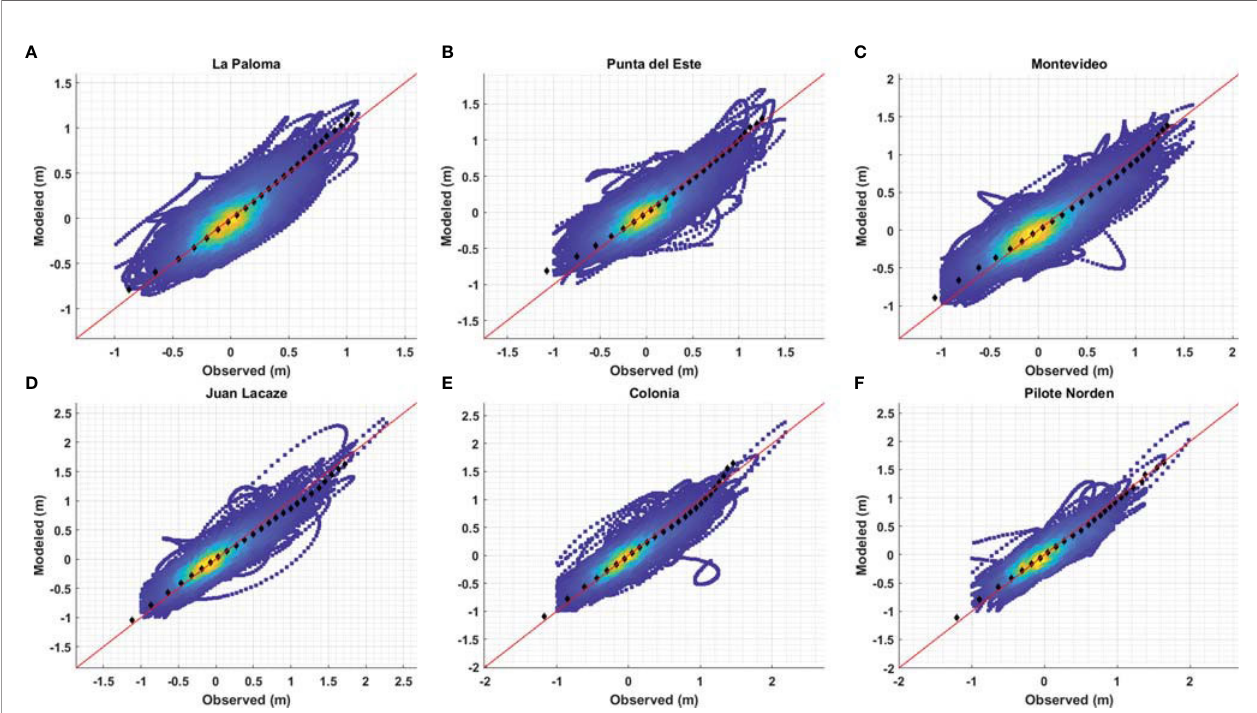
FIGURE 6 | Scatter plot and qq-plot (black) from modeled meteorological tide (m) vs measured meteorological tide (m): (A) La Paloma, (B) Punta del Este, (C) Montevideo, (D) Juan Lacaze, (E) Colonia and (F) Pilote Norden. Only years with less than 50% hourly missing data considered. Read line represents 1-1 and colorscale represents data density (blue less data – yellow more data). 25 equispaced quantiles shown with Gumbel scale ranging from 0.001 to 0.999.